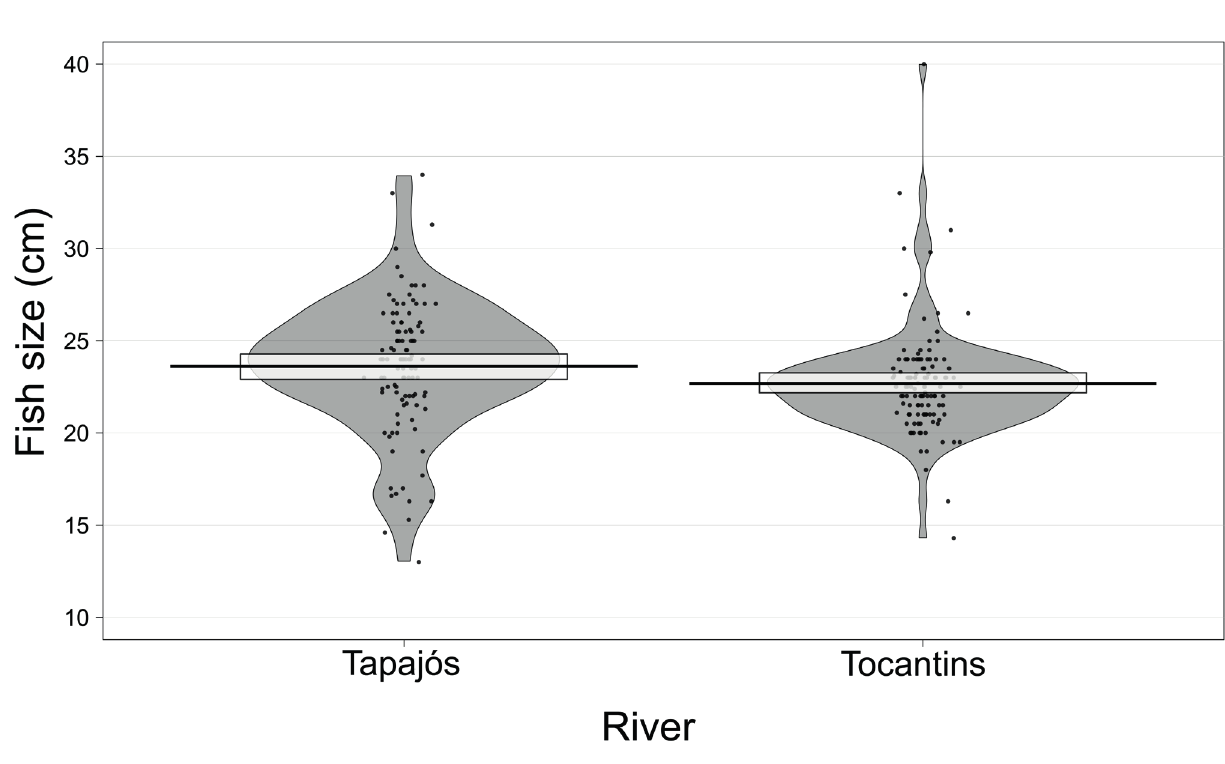
FIGURE 4 | Mean size (standard length in cm) of Plagioscion squamosissimus sampled in the Tapajós and Tocantins rivers. Mean (dark horizontal line), data distribution (bean gray area), data (points), confidence interval (rectangle). The median sizes of P. squamosissimus were 23.6 cm in the Tapajós and 22.7 cm in the